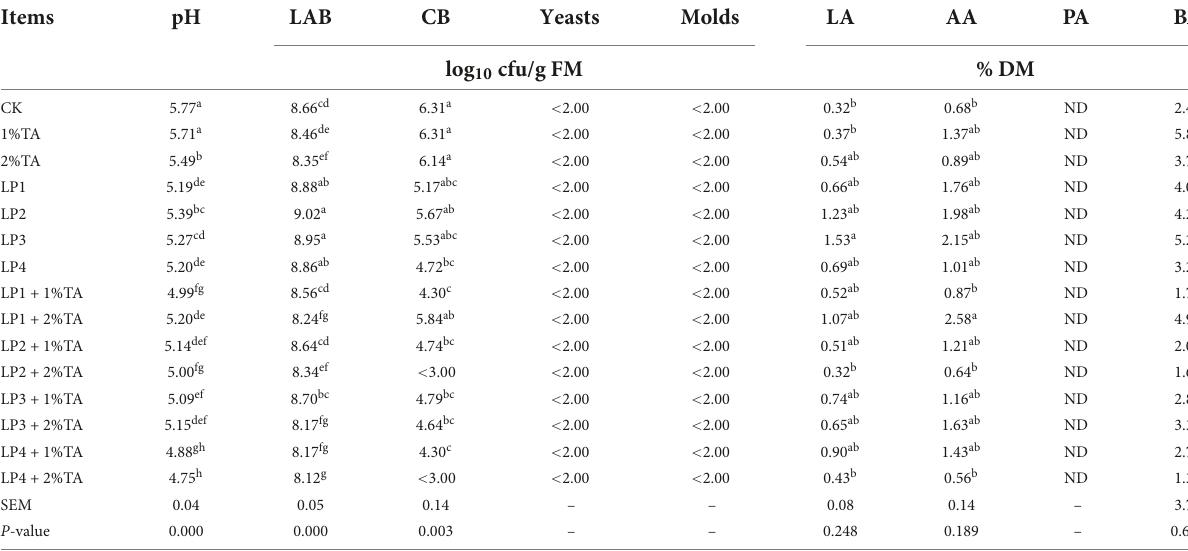
TABLE 3 Effects of the addition of lactic acid bacteria and tannic acid on the fermentation parameters and microbial quantity of silage of soybean.